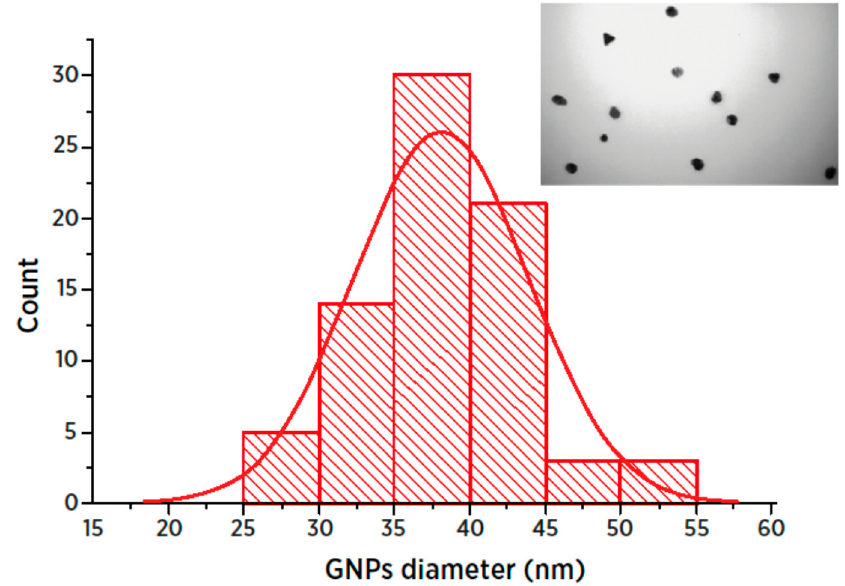
Figure 1. Fragment of gold nanoparticles (GNP) microphotograph and histogram of particle size distribution.